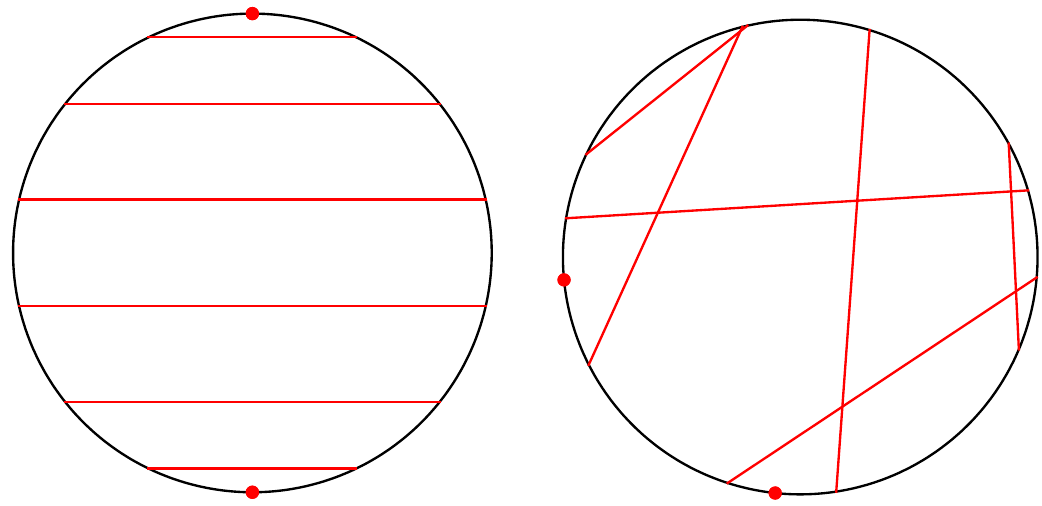
Figure 2 . Visualizations of SU(2) Cardy branes for k = 7 . The figure on the left shows all D-branes with θ = 0 , the right figure shows the same D-branes rotated by random angles θ